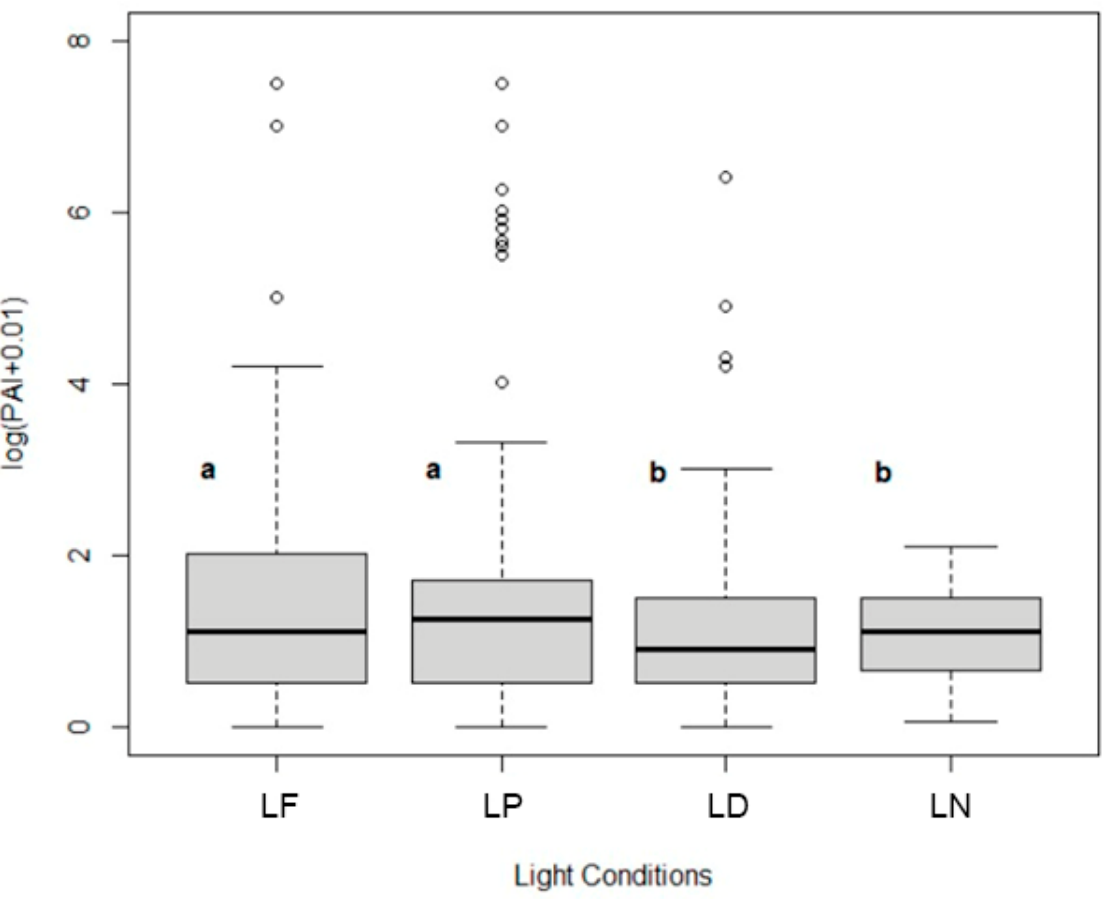
Figure 2. Generalized Linear Model analysis for light exposure in PAI (periodic annual increment) for individuals ≥ 32 cm of DBH in the ombrophilous open forest with lianas. LF—crown receiving full light; LP—crown with partial vertical light, covered by the crown of nearby trees; LD—crown with some side or diffuse light and covered by nearby trees; LN—not evaluated/no crown. Letters “ a ” and “ b ” represent statistical differences. The circles represents outlier values.